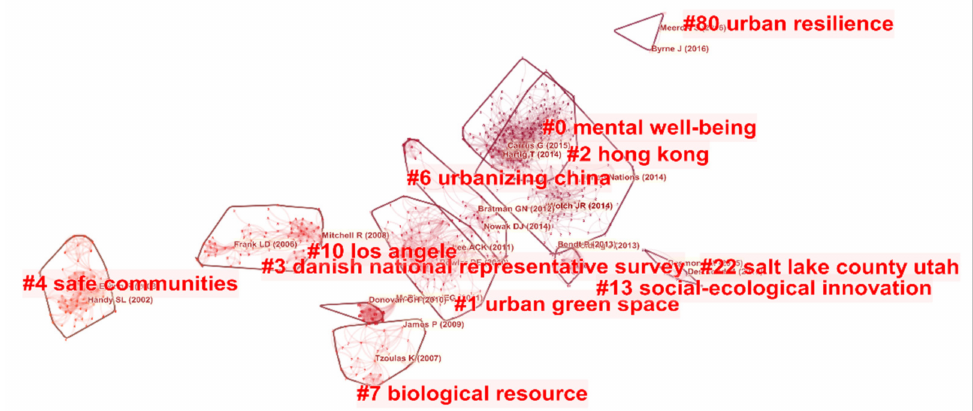
Figure 11. Cluster view of references in healthy urban planning